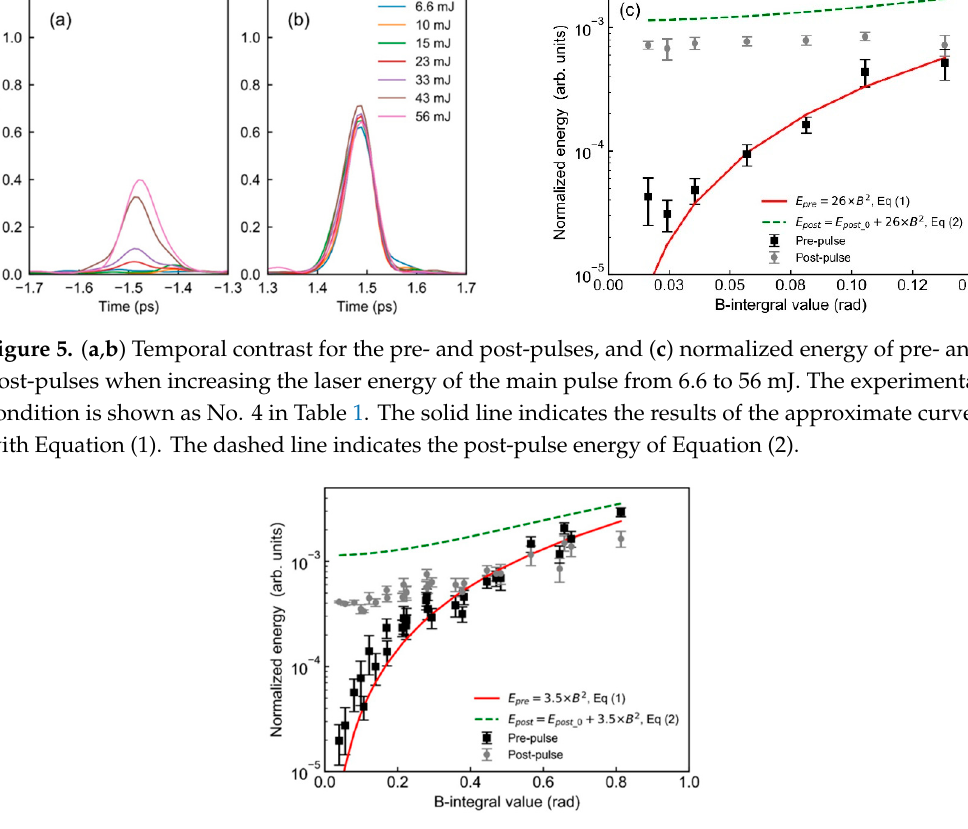
Figure 6. Normalized pre- and post-pulse energies at the B-integral from 6.6 to 640 mJ of laser energy. The solid line indicates the results of the approximate curves with Equation (1). The dashed line indicates the post-pulse energy of Equation (2). The experimental condition is shown as No. 5 in Table 1.